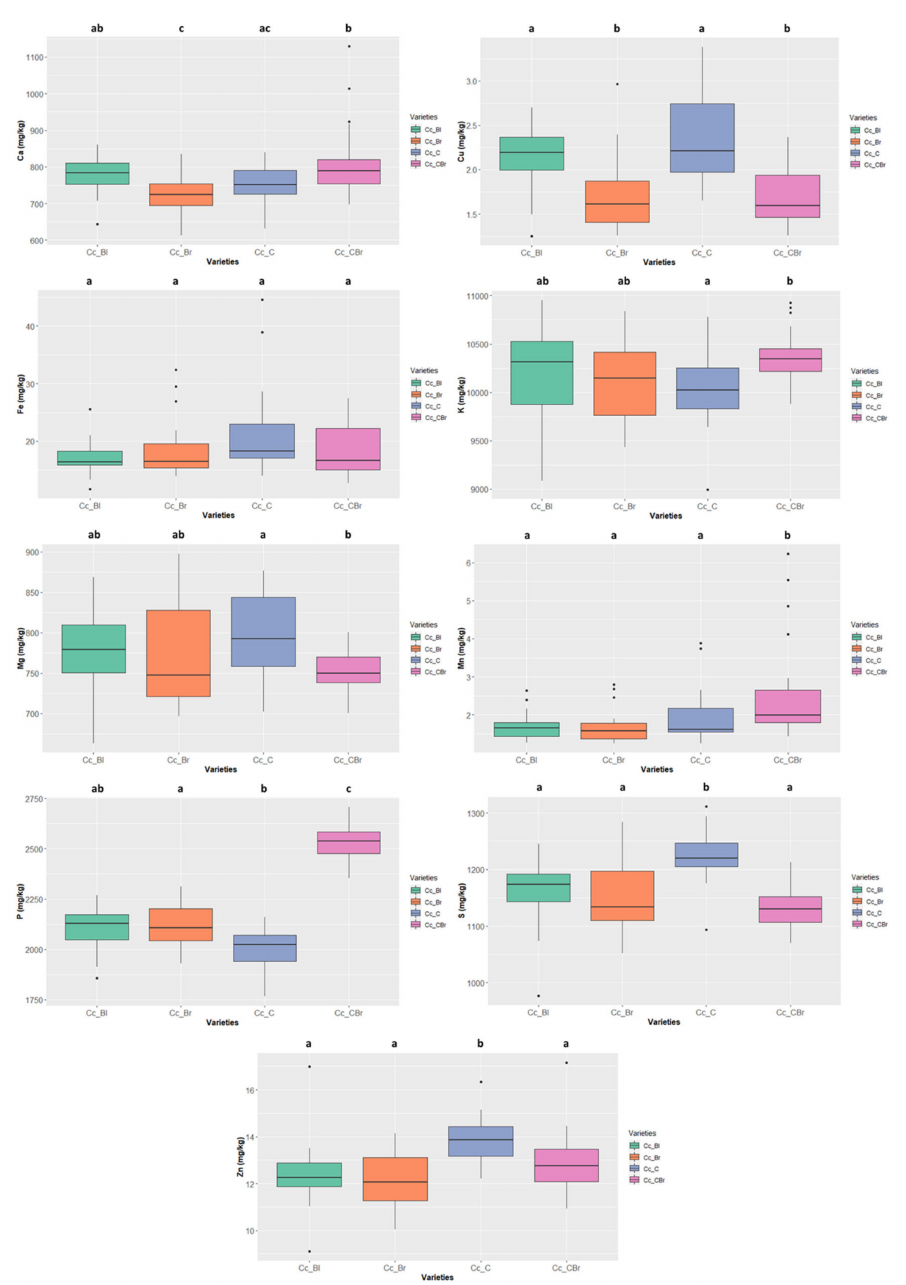
Figure 8. Variation of the content of the 9 minerals quantified in the different colour types of Cajanus cajan . The box represents the 25th, 50th (median), and 75th percentiles, while the whiskers represent the 10th and 90th percentiles with minimum and maximum observations. The dots represent the outliers. Different lower-case letters indicate significance differences ( p < 0.05) between